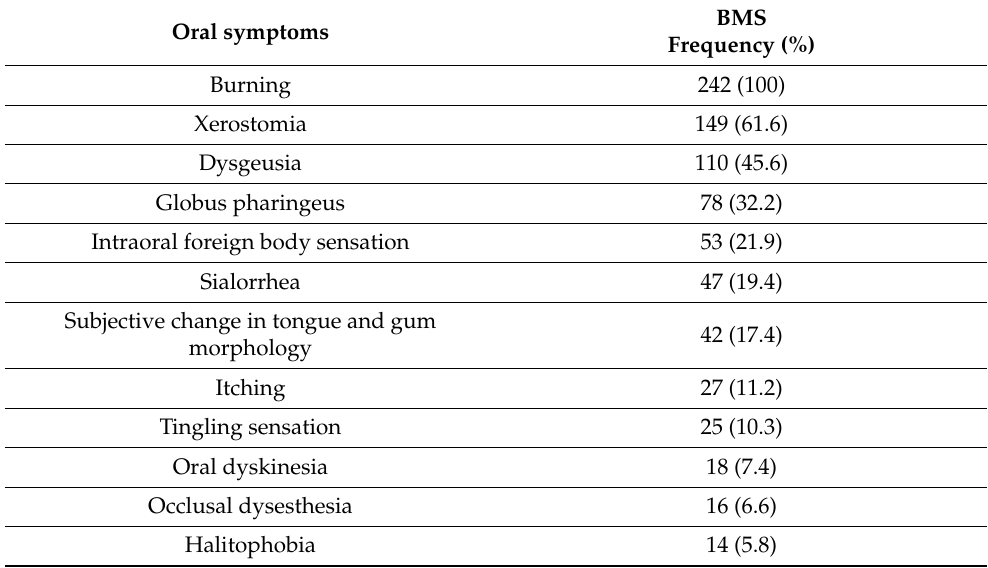
Table 4. Prevalence of oral symptoms and sites involved in 242 BMS